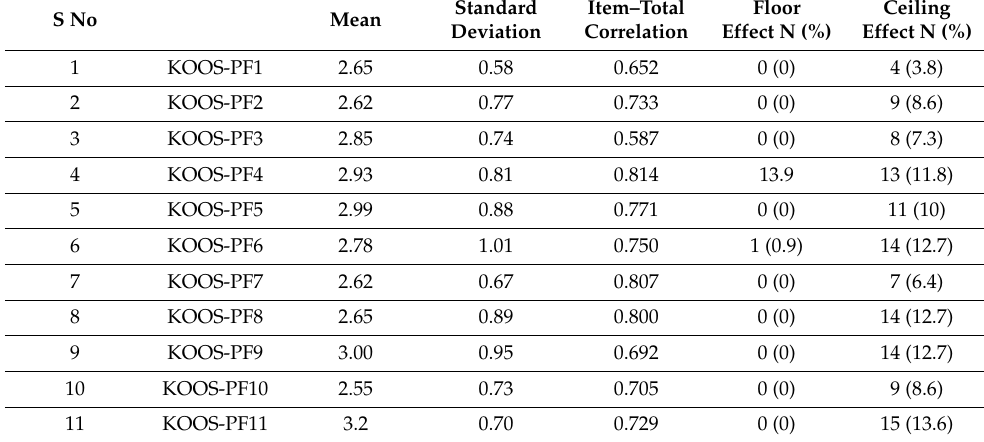
Table 7. The mean, standard deviation, total correlation of items along with floor and ceiling effect of individual items in Ar-KOOS-PF-F ( n =